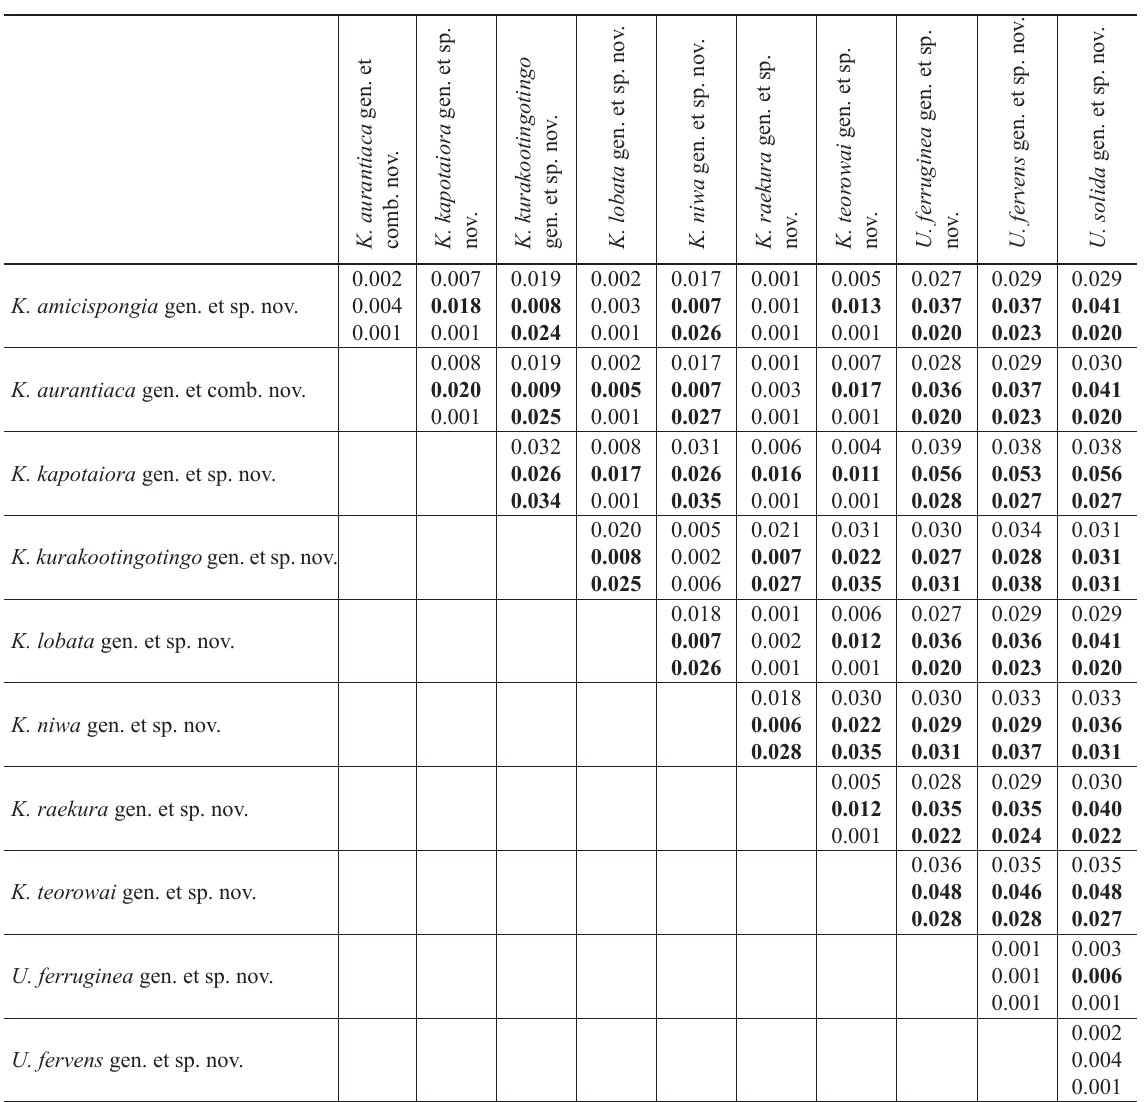
Table 3. Mean interspecific genetic distances for species of Kotatea gen. nov. and Ushanaia gen. nov. The mean uncorrected p-distance for each pairwise comparison is given for concatenated ( mtMutS + 28S ) (top), mtMutS (middle) and 28S (bottom) sequences. For comparison, mean p-distances appear in bold if they match or exceed the threshold for accurate discrimination of species in Alcyonium Linnaeus, 1758 identified by McFadden et al. (2014): 0.005 for mtMutS ; 0.007 for 28S . Note that the same comparison cannot be made for concatenated sequences, since those of McFadden et al. (2014) also included Igr1 and COI